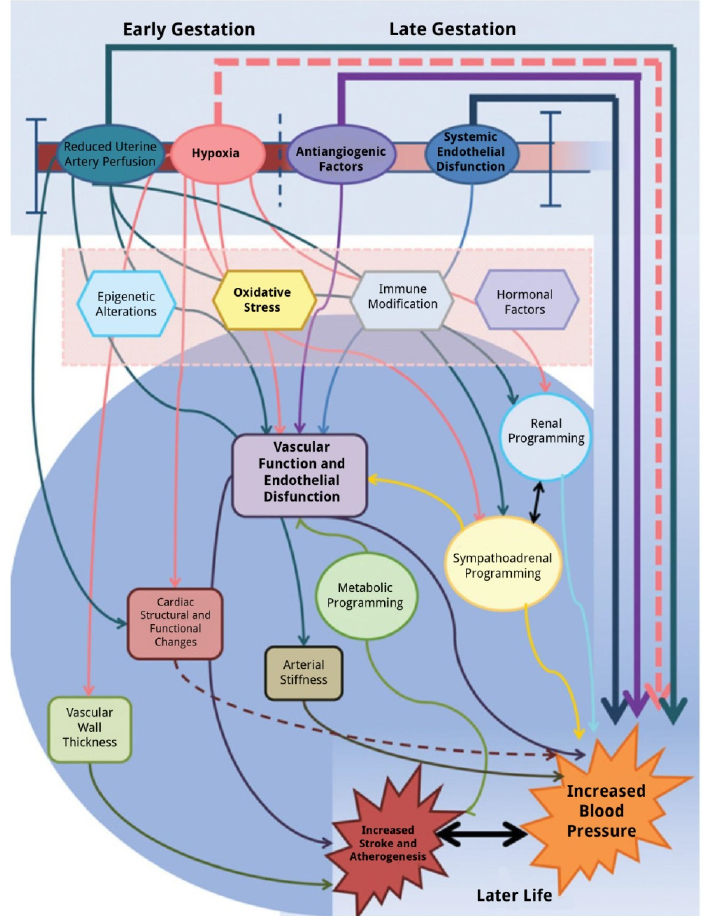
Figure 3. Summary of the potential and demonstrated mechanisms by which in utero exposure to pre-eclampsia may lead to altered cardiovascular physiology and risk in the offspring in later life. Reproduced with permission from: Davies et al., 2012.